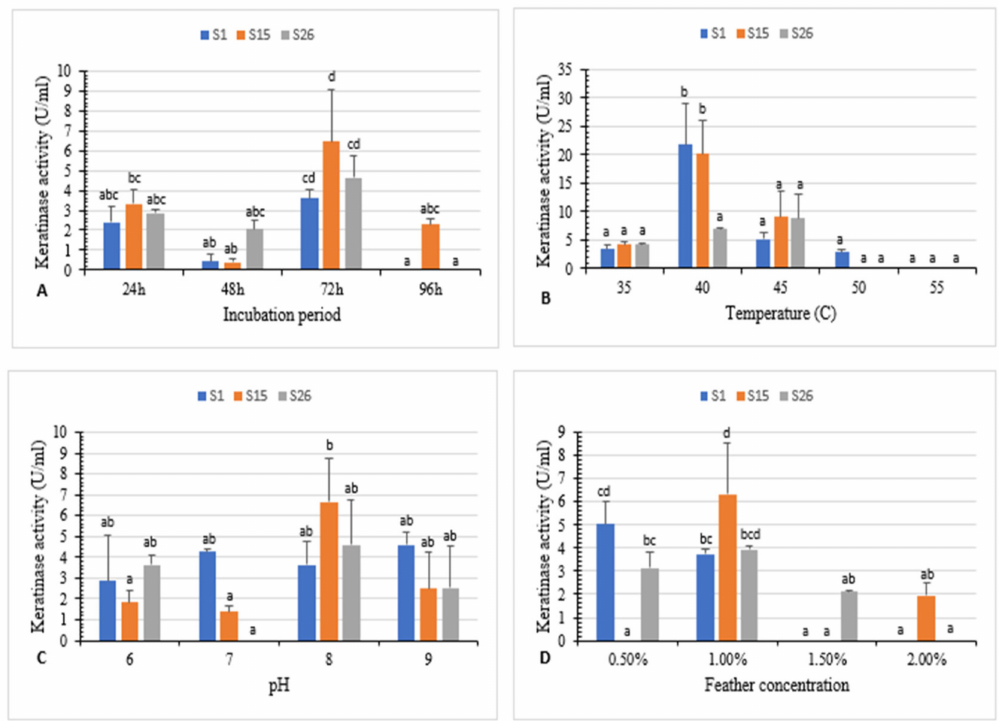
Figure 2. ( A ) Effect of incubation period, ( B ) temperature, ( C ) pH, and ( D ) feather concentration on white chicken feather degradation by isolates S1, S15, and S26. Bars are the standard error of the mean. Mean with the different letters are significantly different according to Duncan’s at p <